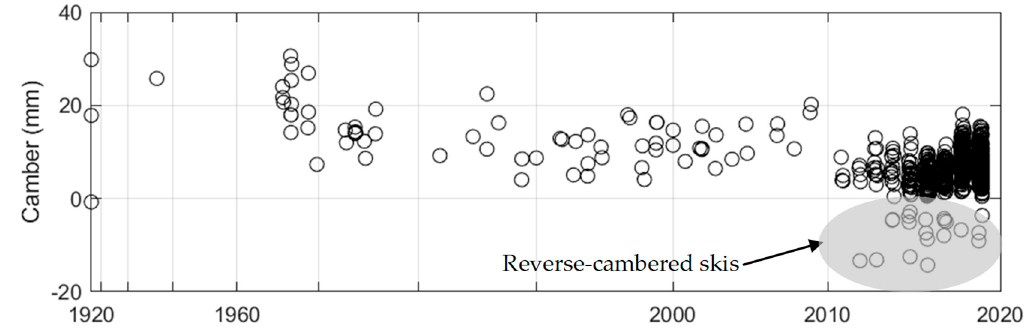
Figure 4. Maximum camber vs. model year. Negative camber represents fully-rockered (or reverse- cambered)